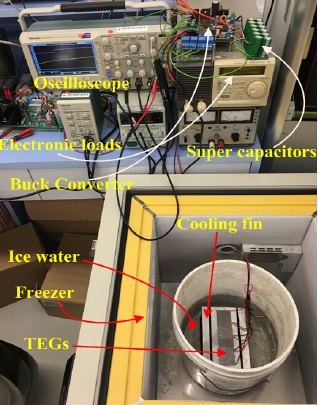
Figure 9. Photograph of the experimental setup of the TE board power generation system.